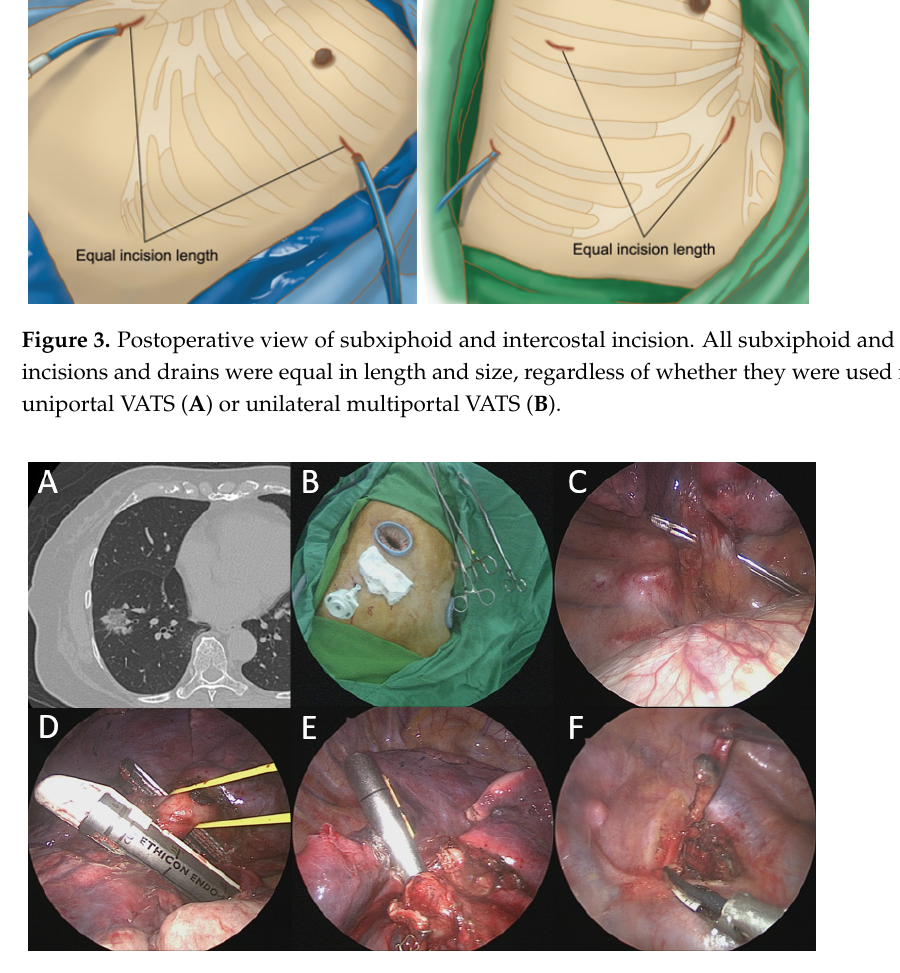
Figure 4. A patient with right lower lung cancer receiving unilateral 3-port VATS right lower lobectomy. ( A ) Computed tomography scan showed a right lower lung part-solid ground-glass nodule (2.0 cm). ( B ) Equal-length incisions (3 cm) made over subxiphoid and 5th intercostal space as well as another 1-cm incision over 7th intercostal space. ( C ) Inferior pulmonary vein identified and transected via subxiphoid incision. ( D ) Basal trunk of pulmonary artery transected by endostapler via subxiphoid incision. ( E ) Right lower lobe bronchus transected by endostapler via subxiphoid incision. ( F ) Upper mediastinal lymph node dissection using harmonic scalpel from 5th intercostal incision. Table 2. Perioperative details of patients with unilateral VATS ( n = 33).